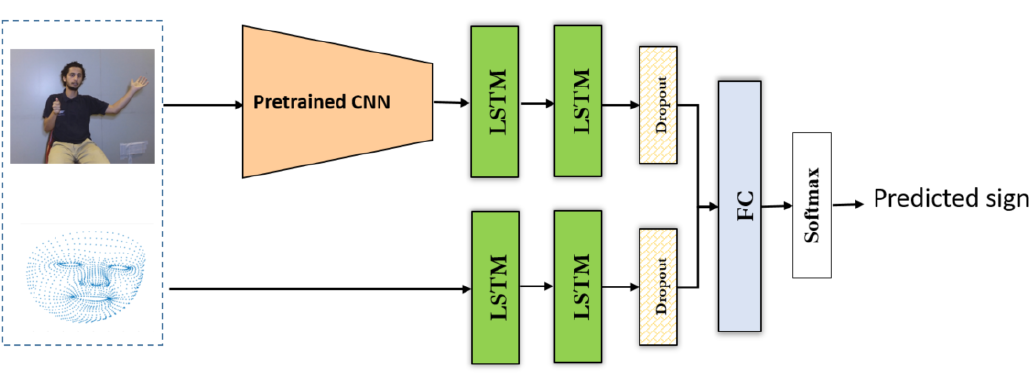
Figure 7. Manual and non-manual fused system.